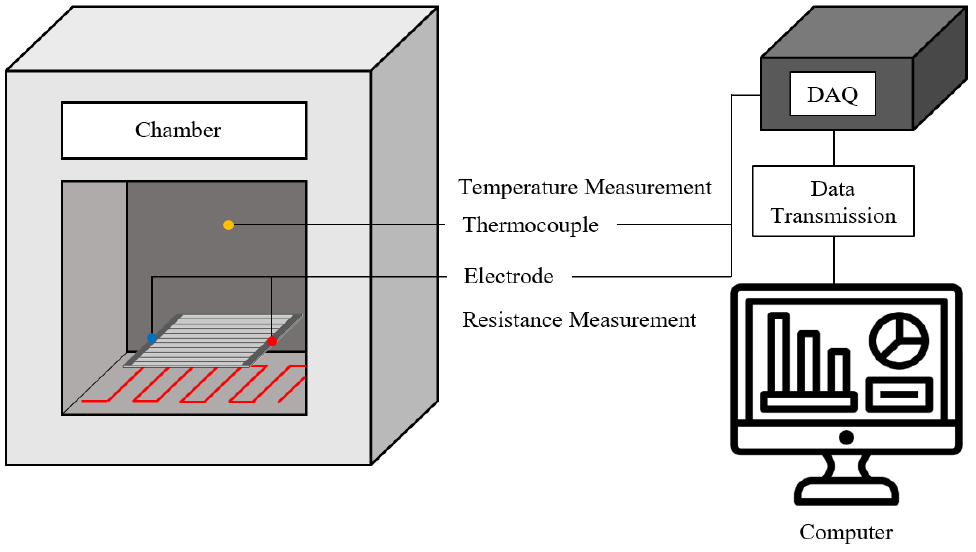
Figure 6. Schematic diagram of resistance measurement of fabricated temperature sensors.